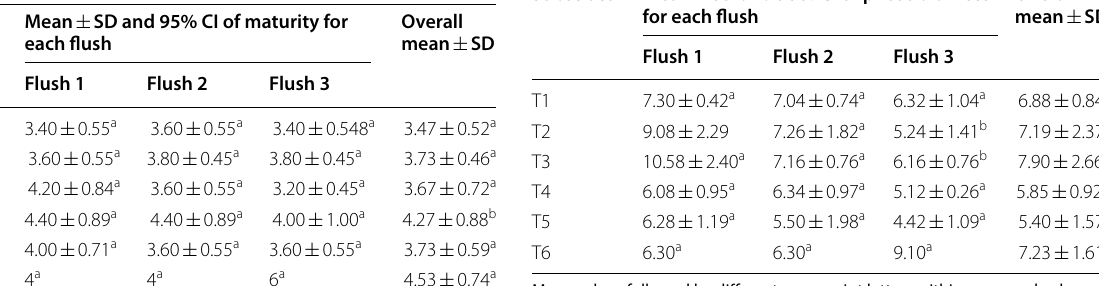
Table 6 The effect of substrates on Pileus diameter (cm) Substrate Mean SD and 95% CI of pileus diameter ± for each